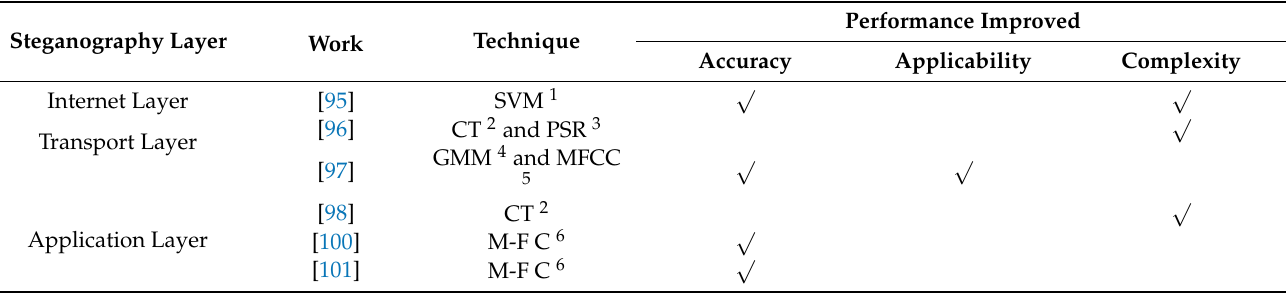
Table 12. Steganalysis methods based on